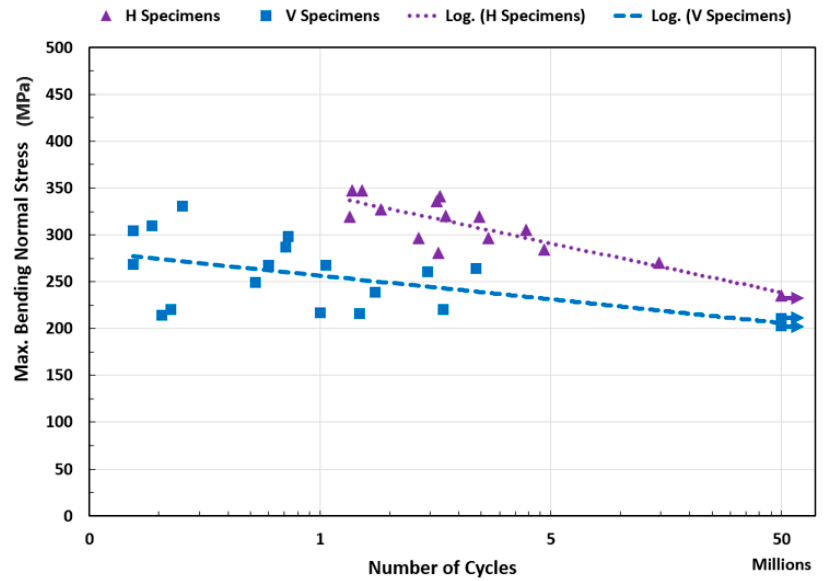
Figure 11. Ultrasonic bending fatigue test results (stress–life best fit curve) for H and V specimens.